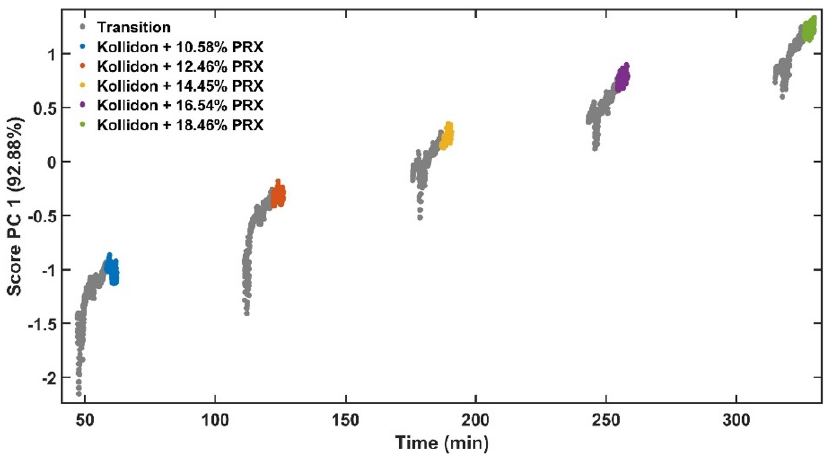
Figure 8. Scores of PC1 vs. experiment time with transition data.